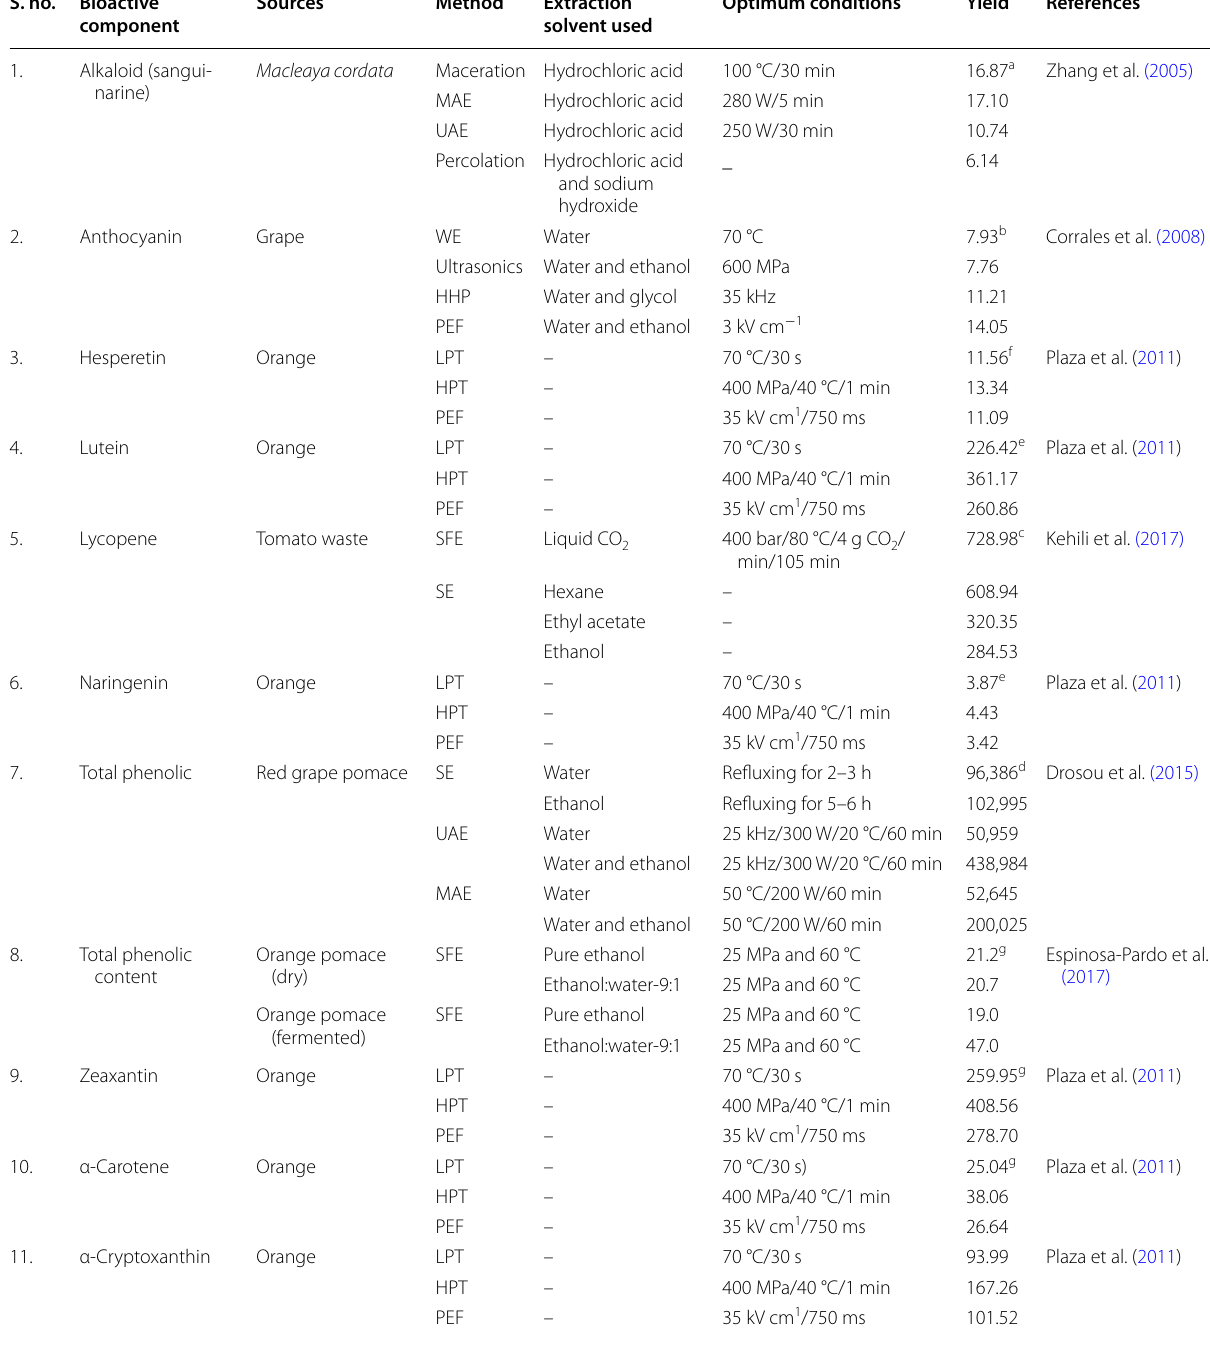
Table 3 Comparative evaluation of different extraction techniques for extraction of bioactive